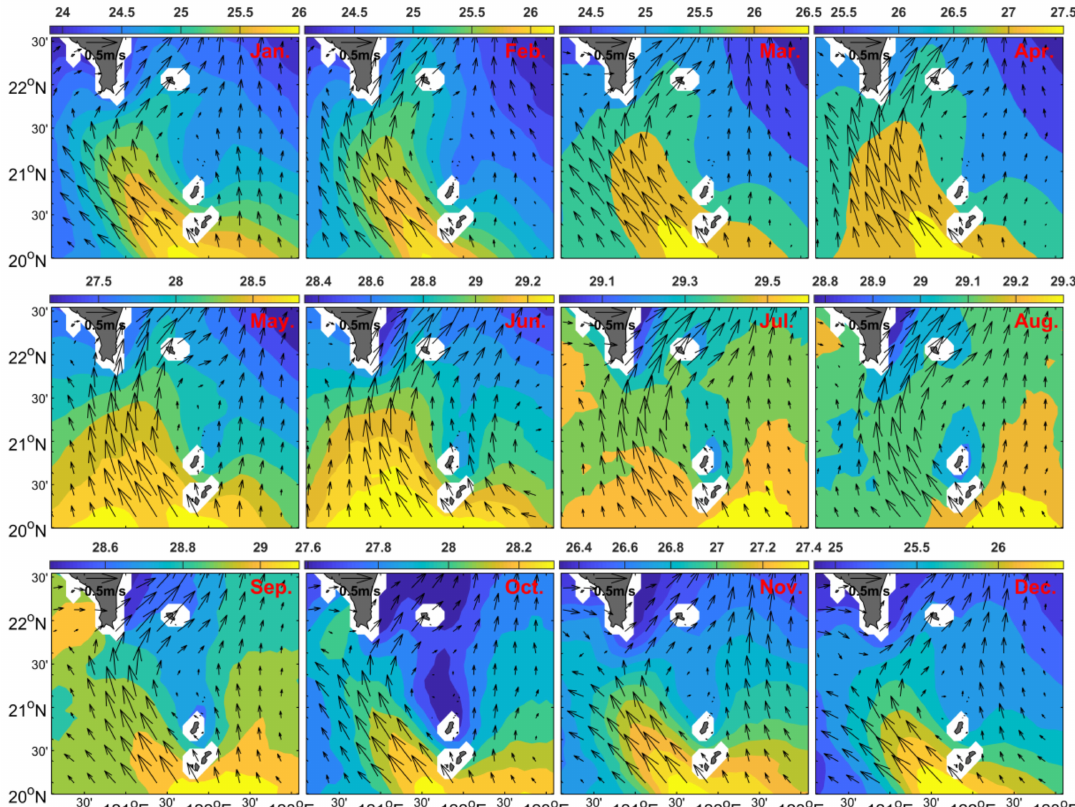
Figure 6. Seasonal variability of SST and geostrophic current around the LS. SST ( ◦ C, in color); Geostrophic current (m/s, in